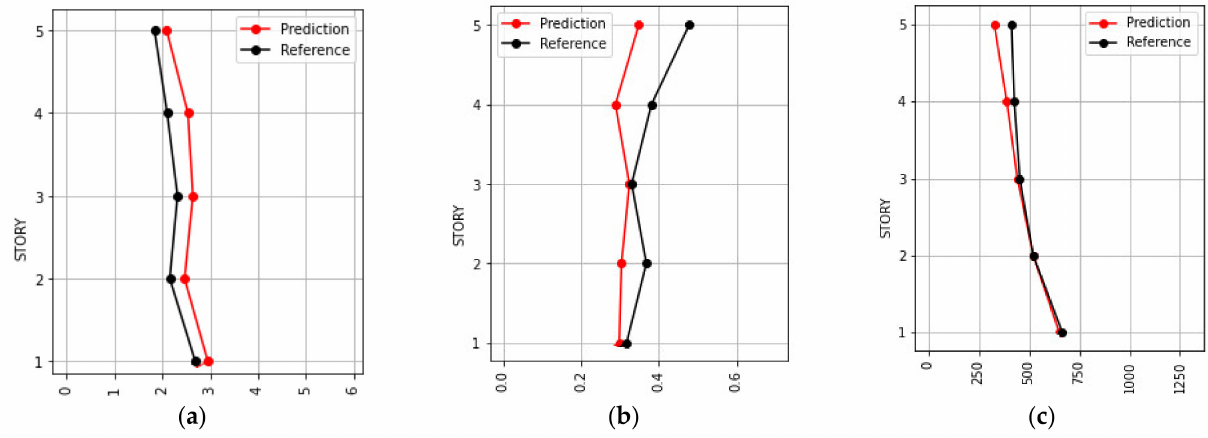
Figure 22. Prediction and reference values on each floor of the Petrolia California N–S record and scale factor that produces Sa(T 1 ) = 875 gal for the validation process of ( a ) Ductility ratio; ( b ) Story drift ratio, and ( c )